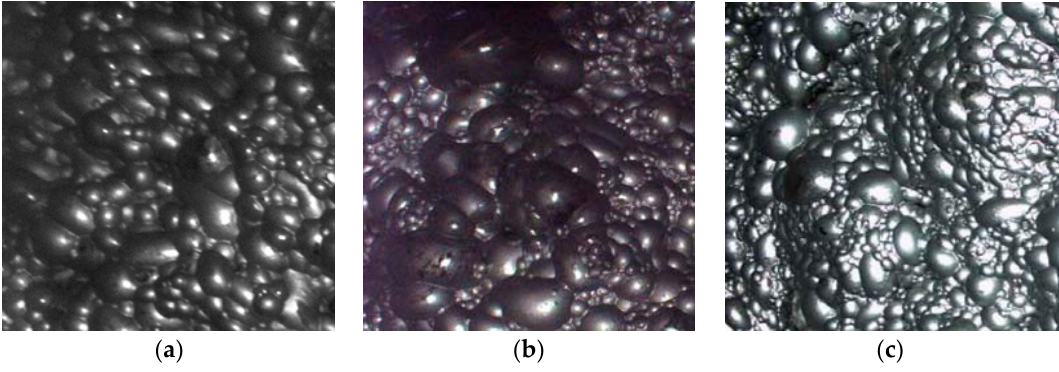
Figure 1. Comparison of images acquired by three kinds of illumination, with the same illumination and different lamps. ( a ) PHILIPS E27 Fluorescent; ( b ) PHILIPS MHN-TDW Halide; ( c ) HY 03-033 Lamp.